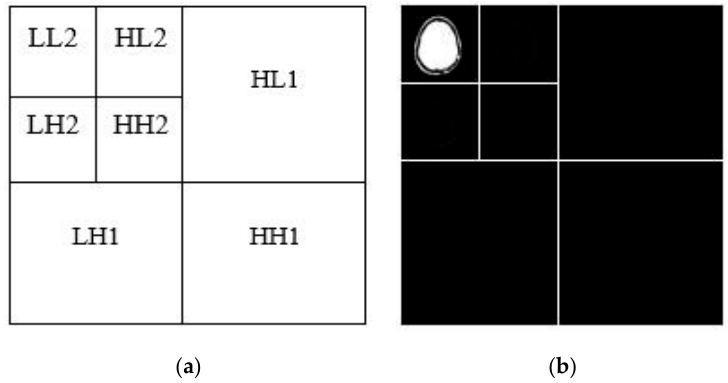
Figure 6. ( a ) Structure of second level DWT, ( b ) Second level DWT of the image.